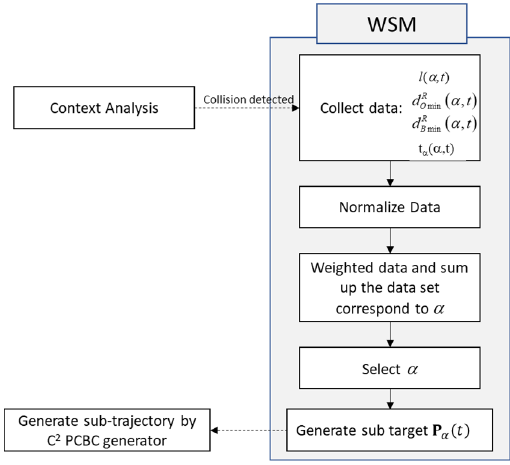
Figure 14. The WSM flow chart.